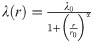
The farm-to-farm and farm-to-resident Q fever transmission kernel as a function of the source-receptor distance, displayed on a log-log (upper panel) and log-linear (lower panel) scale. The smooth curves are obtained by plotting the analytical expression of the transmission kernel (λ(r)=λ01+(rr0)α) for the parameters in Table 1.